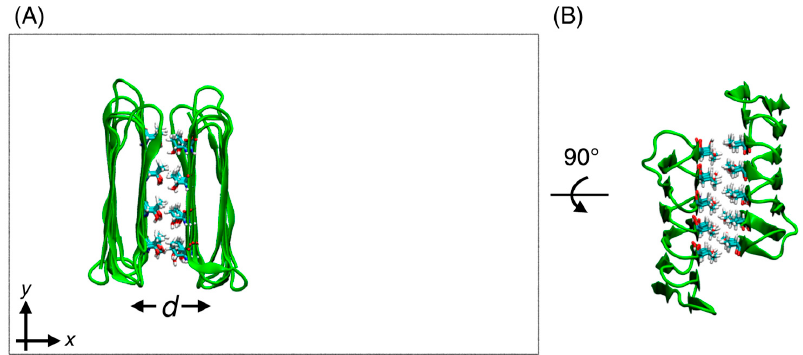
Figure 1. A dimer of Ri AFP ( Rhagium inquisitor antifreeze proteins) dissolved in water in the configurations: ( A ) end-on with the simulation box dimension (black lines) and ( B ) with 90° rotation. The Thr residues involved in the protein–protein contact are represented by sticks. Water molecules and ions are not shown. The two-way arrow indicates the distance d between the centers of mass of the Ri AFPs parallel to the x-axis. d for this conformation is 1.50 nm.